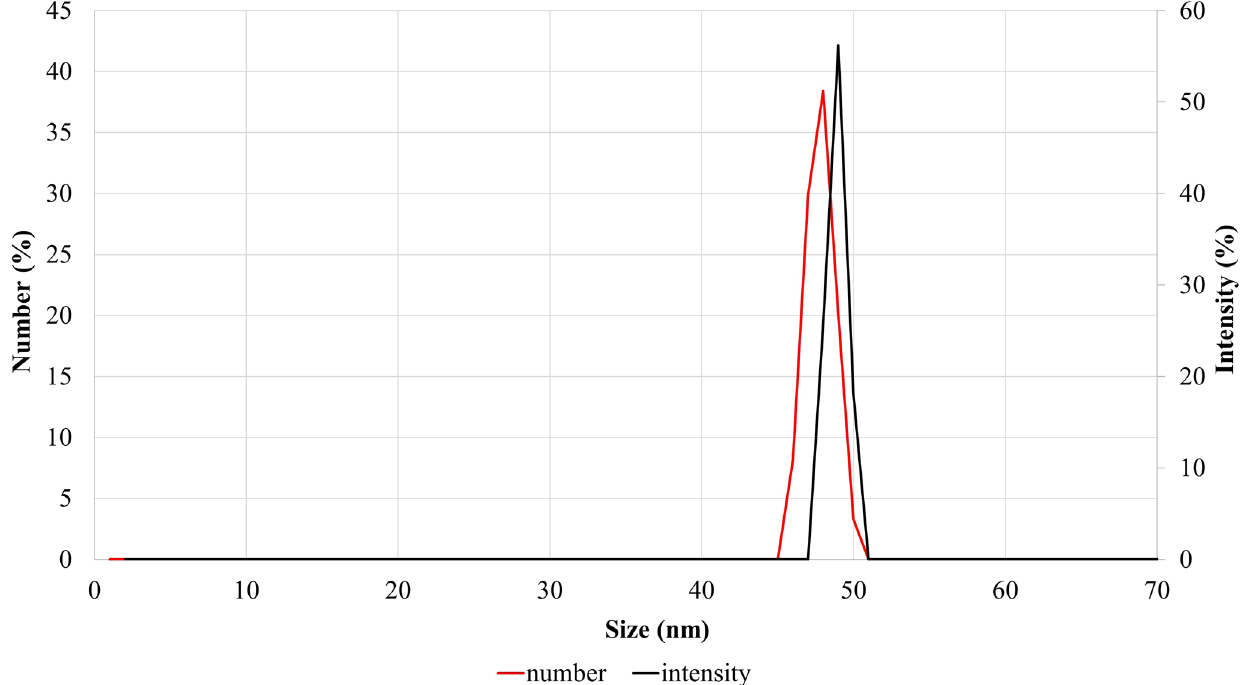
FIGURE 4 - Size distribution of magnetite-chitosan beads with DLS ([Na SO .10H O] = 1.1 wt% ; [chitosan] 2 4 2 final amount leads to the formation of relatively larger nanobeads having narrower size distribution without further